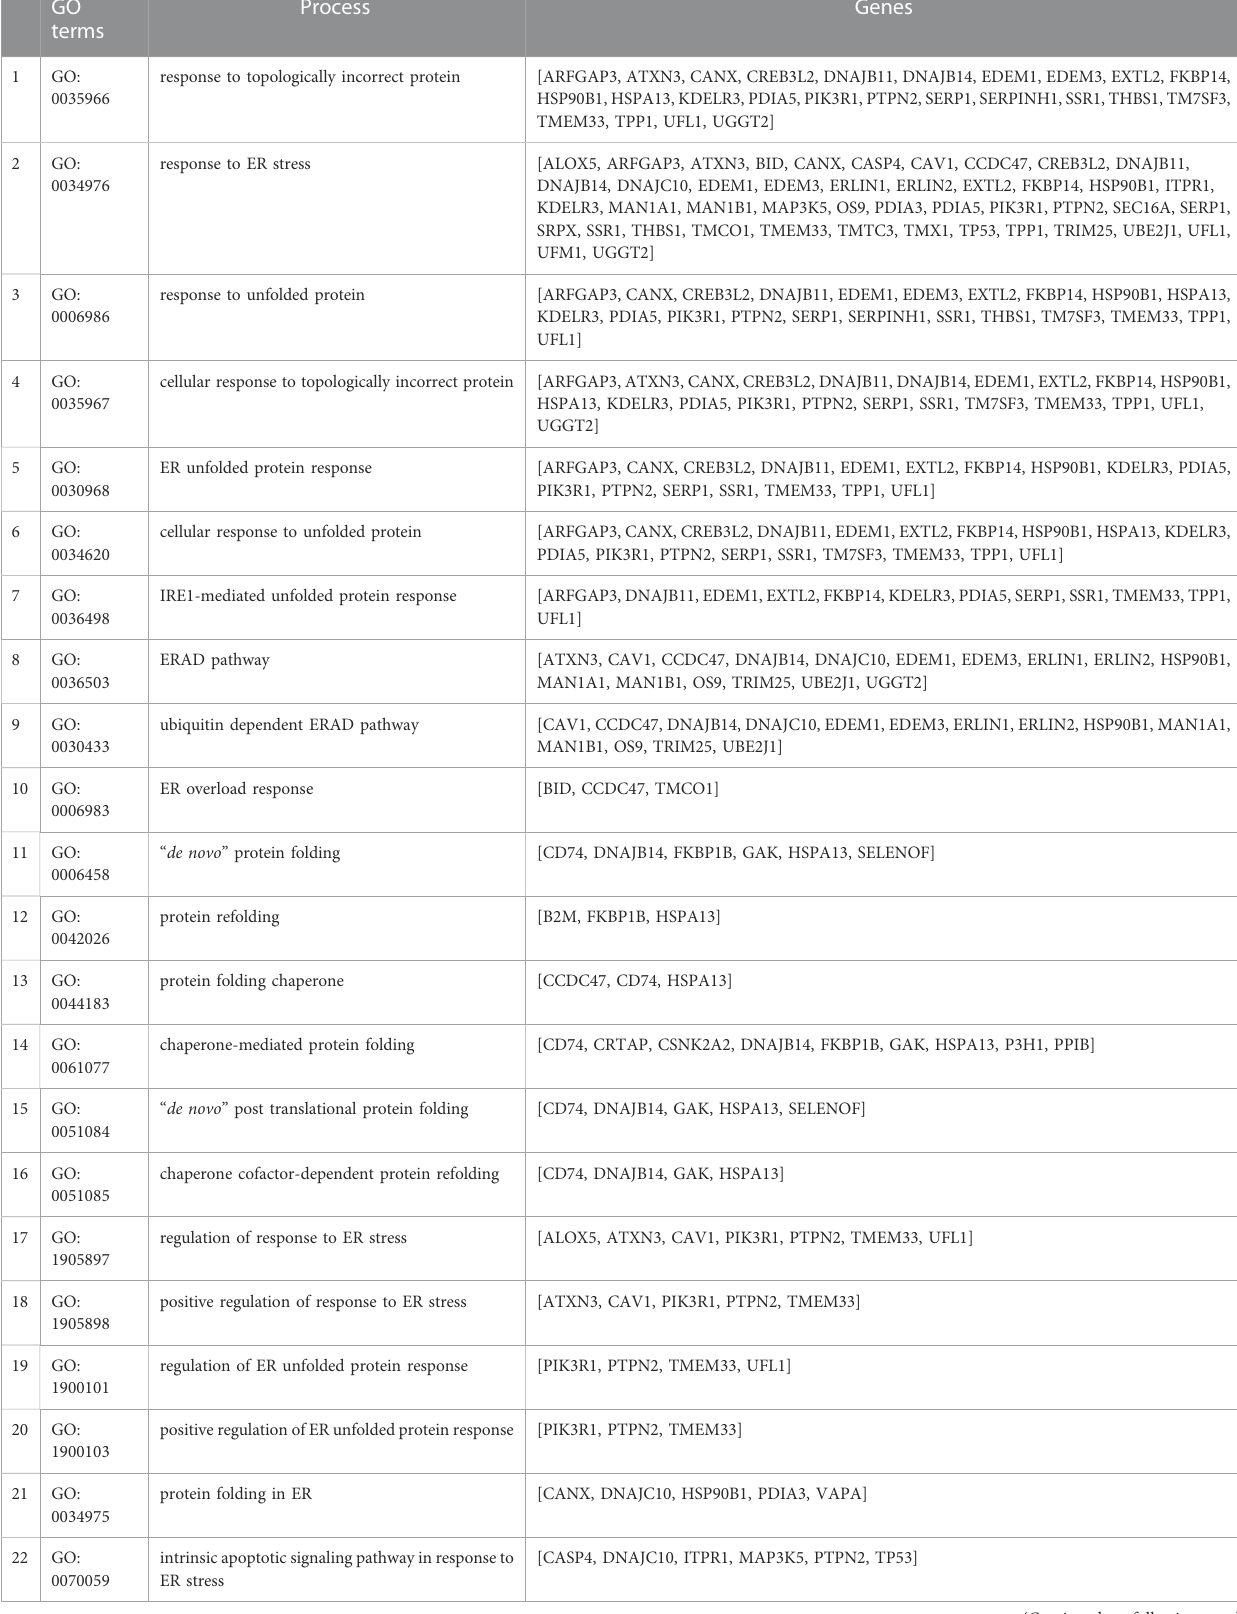
TABLE 2 Gene ontology (GO) processes identi fi ed for the 58 upregulated ER stress- and UPR-related genes from the human Affymetrix chip analysis with p-adjusted (BH) < 0.1.Theontology analysesforallthe differentially expressedgeneswereperformedinClueGOinCytoscape.Nosigni fi cantlyenrichedERstress- and UPR-related processes were identi fi ed with downregulated